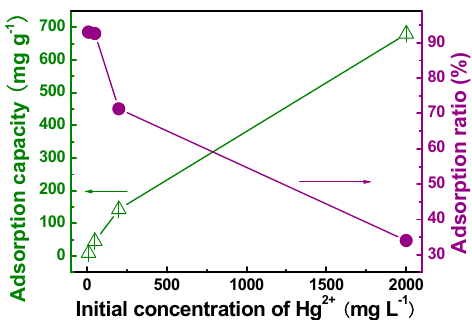
Figure 11. Adsorption capacity and adsorption ratio of Hg 2+ onto 50 mg of PBT at 25 °C in 50 mL solution at different initial ion concentrations for 24 h.